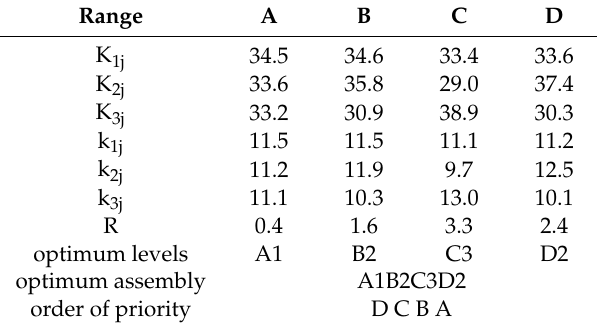
Table 5. Range analysis of